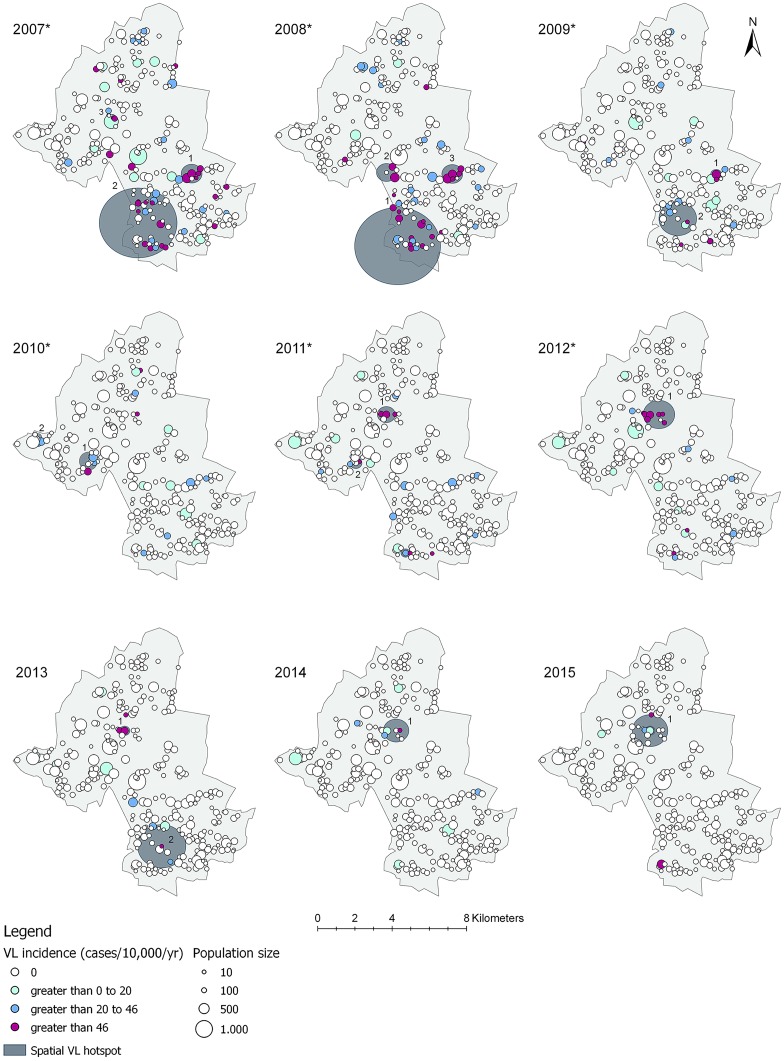
Spatial distribution and incidence (cases/10,000/year) of visceral leishmaniasis (VL) per hamlet, with detected hotspots (dark grey circles) within the study area of Muzaffarpur, Bihar, India between 2007 and 2015.The years with an Asterix (*) represent significant spatial autocorrelation of VL incidence between hamlets as identified using Moran’s I. The cluster numbers correspond with the numbers of the clusters identified per year using spatial scan statistics (S3 Table).